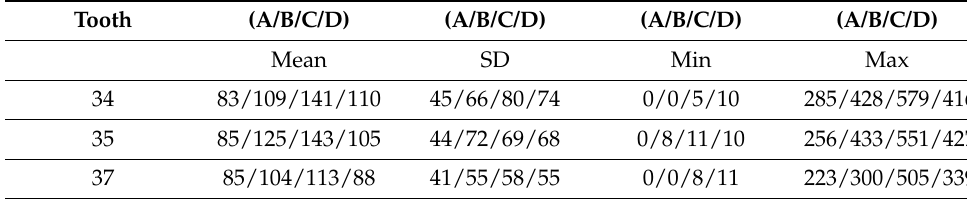
Table 2. Gap sizes of FPDs according to the tooth and the CAD/CAM system ( µ m). Tooth